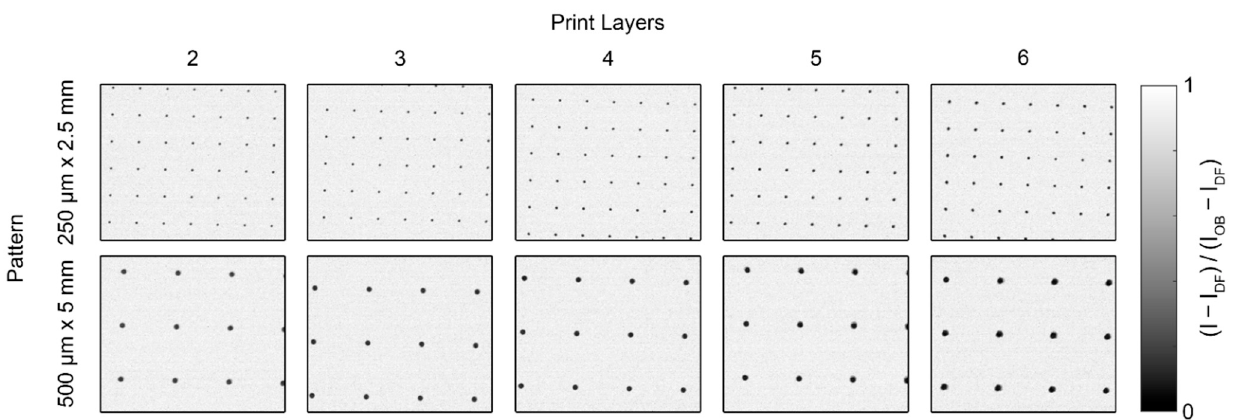
Figure 7. Composite normalized images of the prototype BB grids measured at BT2.